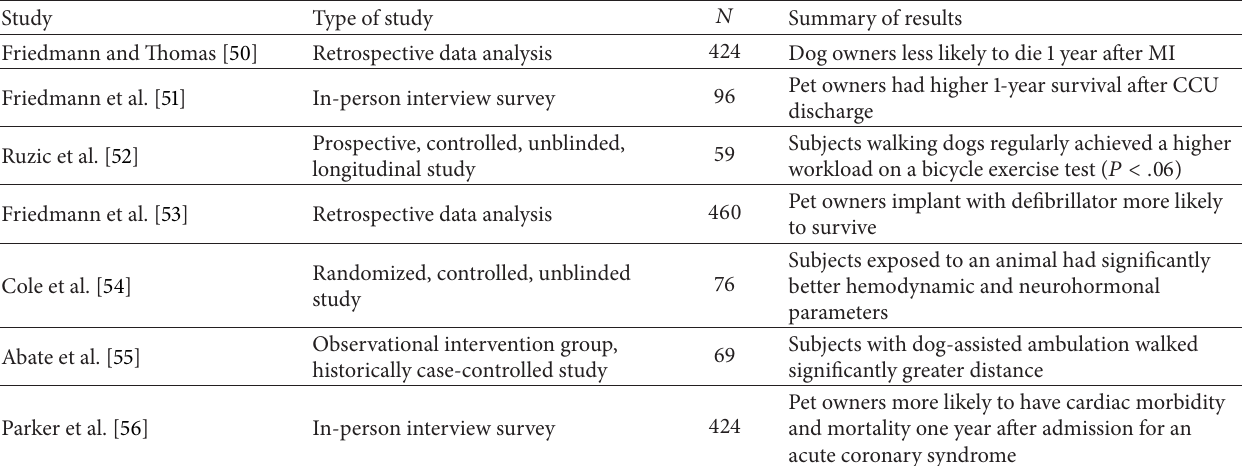
Table 4: Studies on the use of animals in cardiovascular